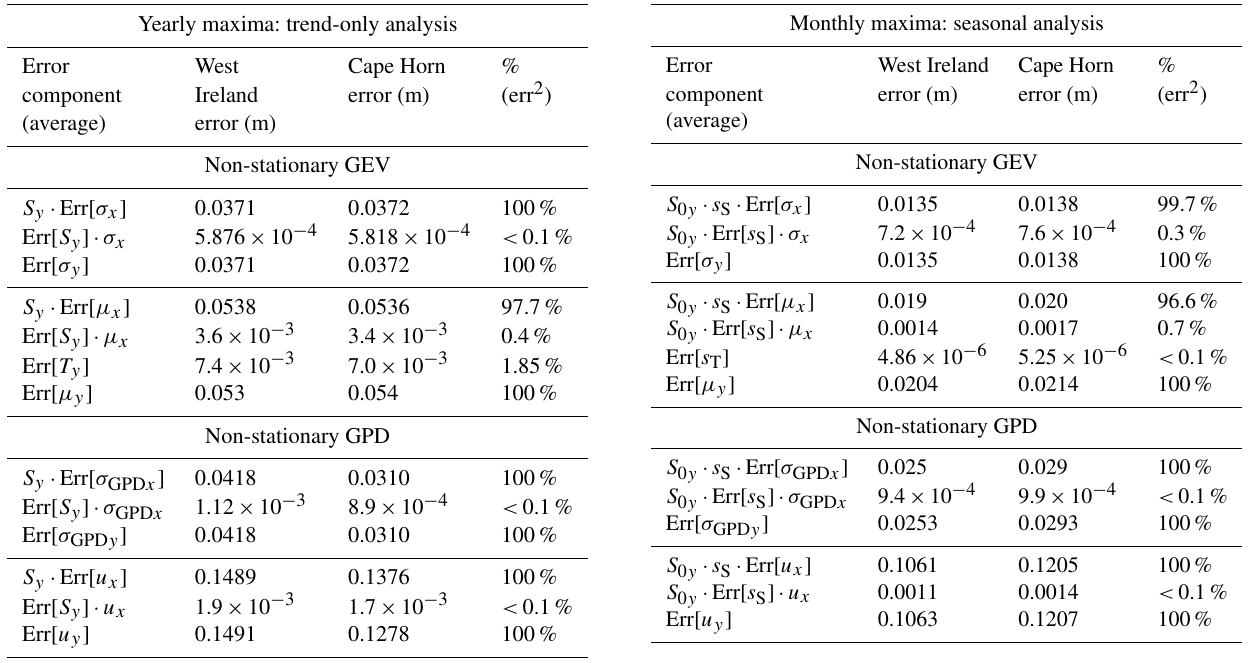
Table 1. Average error components for the long-term analysis of the projections of significant wave height extracted at west Ireland and Cape Horn, for non-stationary GEV and GPD. The error is domi- nated by the component due to the stationary MLE.